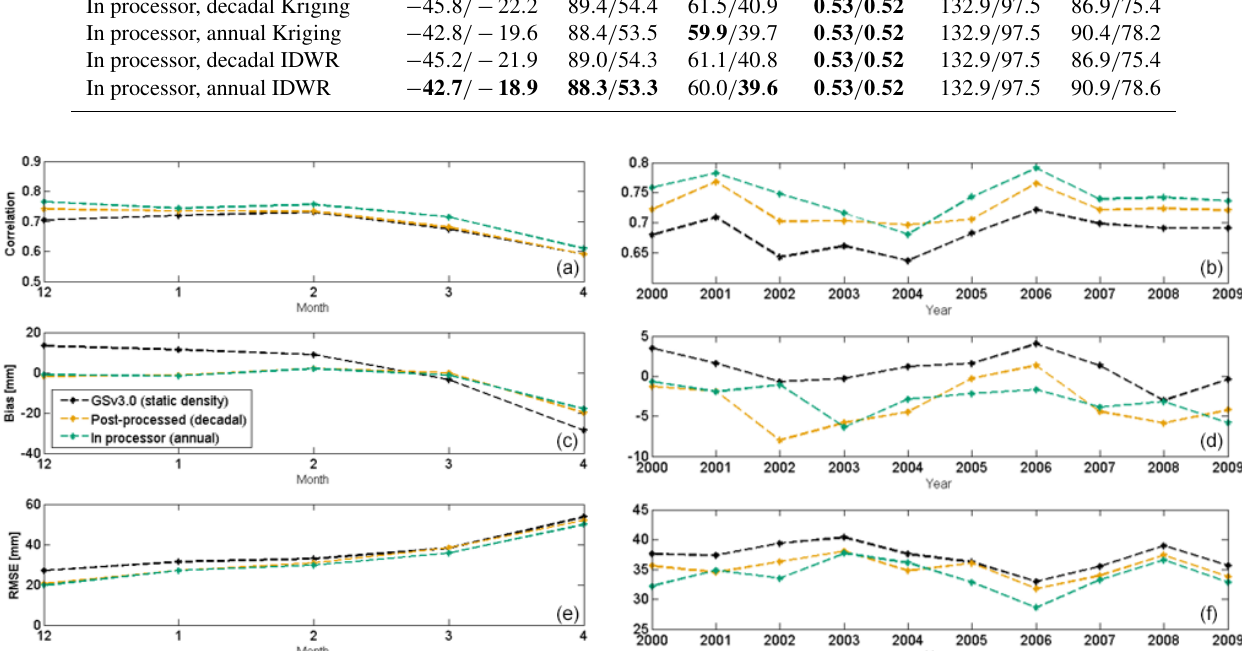
Figure 8. Correlation, bias, and RMSE by month (a, c, e) and year (b, d, f) against validation data.